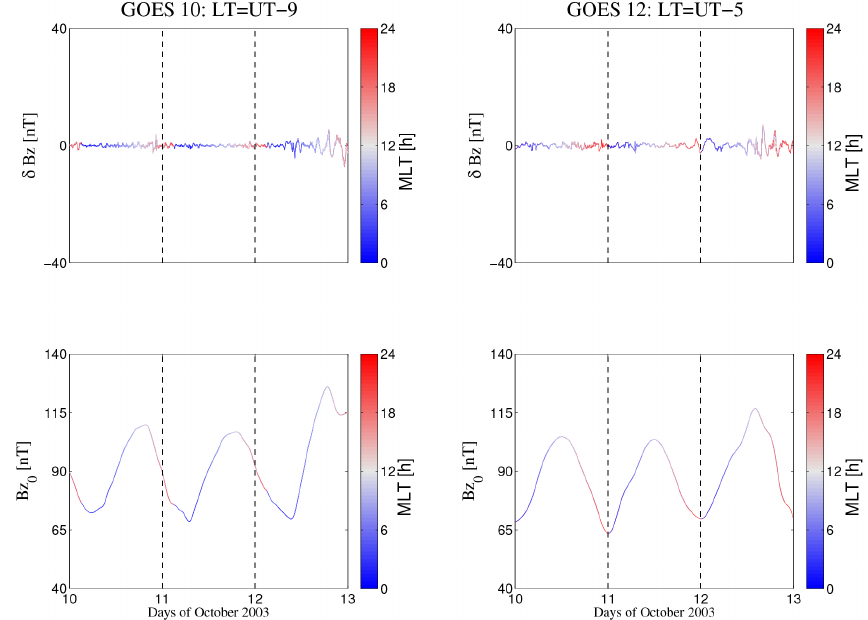
Figure 8. SSQ, 10–12 October 2003: EMD reconstruction for GOES10 (left panels) and GOES12 (right panels) geosynchronous observa- tions. The time resolution is